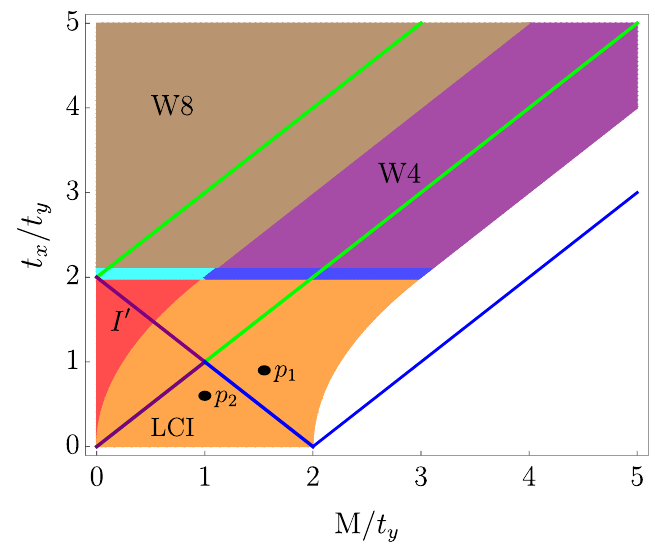
Figure 8: The phase diagram for q = 200. The blue, green and purple straight lines are the phase boundaries when B = 0 (see Fig. 1a for details). Clearly, for very large q , the phase diagram looks much simpler with just four nontrivial phases W8 (brown), W4 (purple), LCI (orange) and I (cid:48) (red), and of course the trivial insulator phase. We note that the regions occupied by I (cid:48) , a significant part of the LCI and the normal insulator (NI) above the blue straight line were semimetallic when the external magnetic field was zero. As q → ∞ , the widths of the blue region which consists of many copies of W2 and W2 (cid:48) phases as well as the cyan region which = 2 t consists of many copies of W2, W2 (cid:48) , W4, W6, and W8, shrink to zero at t c . y x Along the M direction, the LCI phase expands upto M c = 3 t in the q → ∞ limit. y The critical values M c and t c are derived in Appendix D and also discussed in x